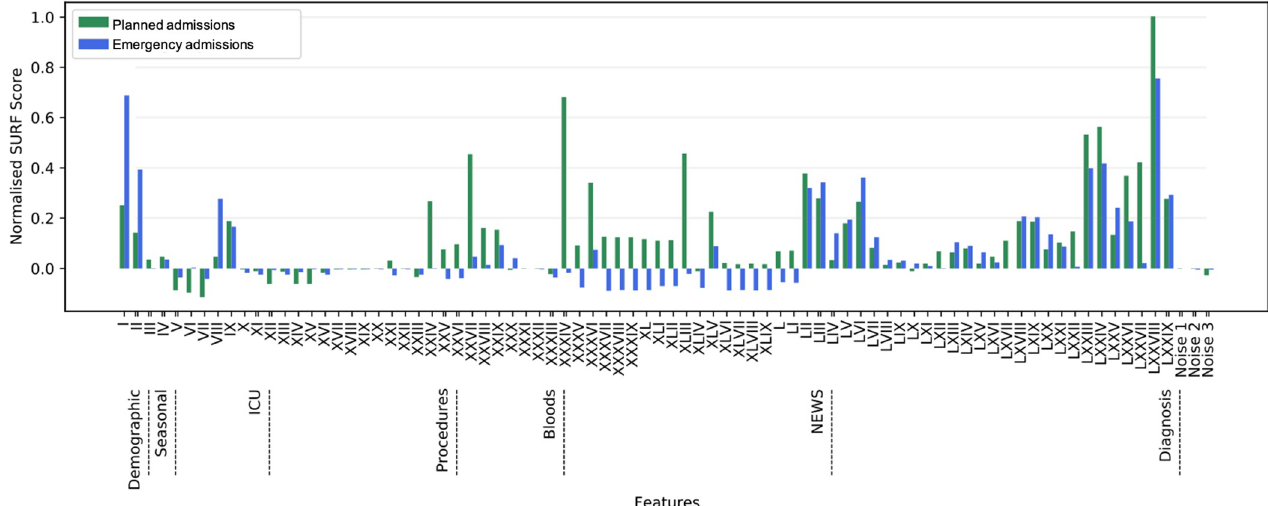
Fig 2. Normalised SURF feature selection scores. The normalised scores resulting from our feature selection methodology, using the SURF feature selection algorithm, for each feature in the datasets. The features on the x-axis of this plot are summarised in Table 4.